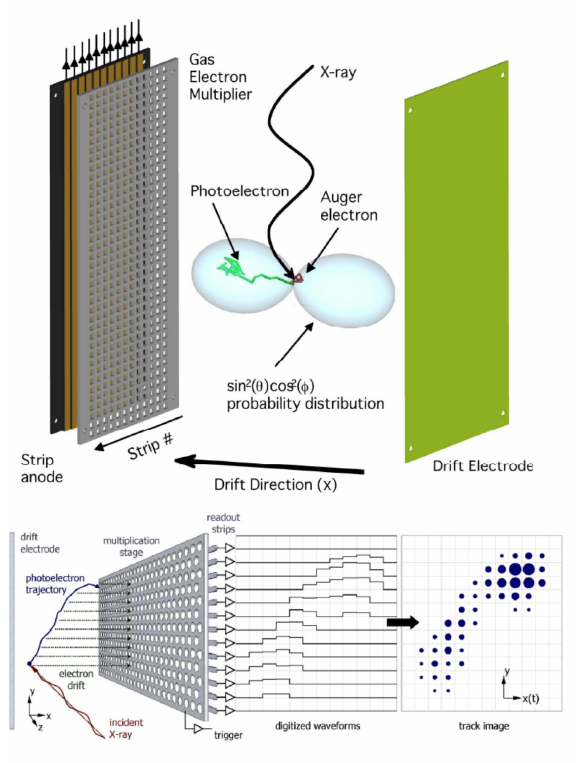
Figure 5. The TPC polarimeter concept